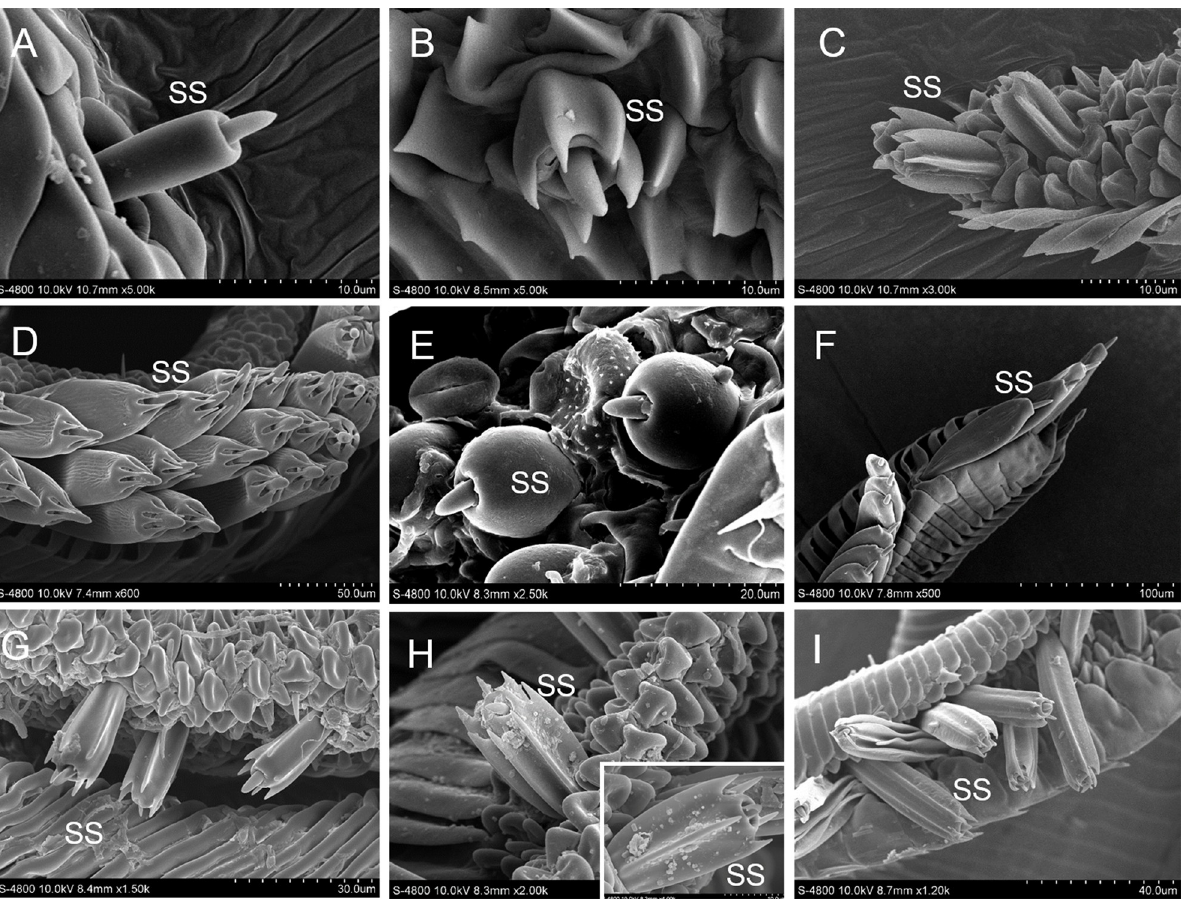
Fig 4. Sensilla styloconica (SS). A: P . guttata ; B: Co . fieldii ; C: Ce . oreas ; D: Sa . charonda ; E: A . issoria ; F: St . neumogeni ; G: SS with six longitudinal ribs of Ca . suroia ; H: SS with five and seven longitudinal ribs of Ca . suroia ; I: L . celtis .